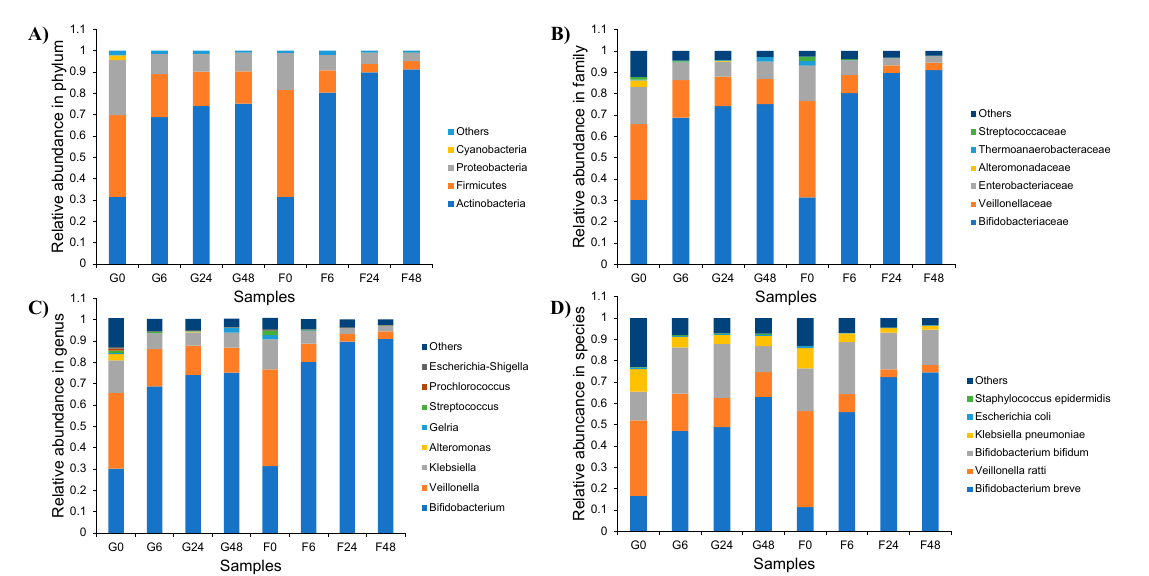
Figure 6. Relative abundance of bacterial community at the phylum ( A ), family ( B ), genus ( C ) and species ( D ) levels during inulin-FOSs extract and glucose fermentation.